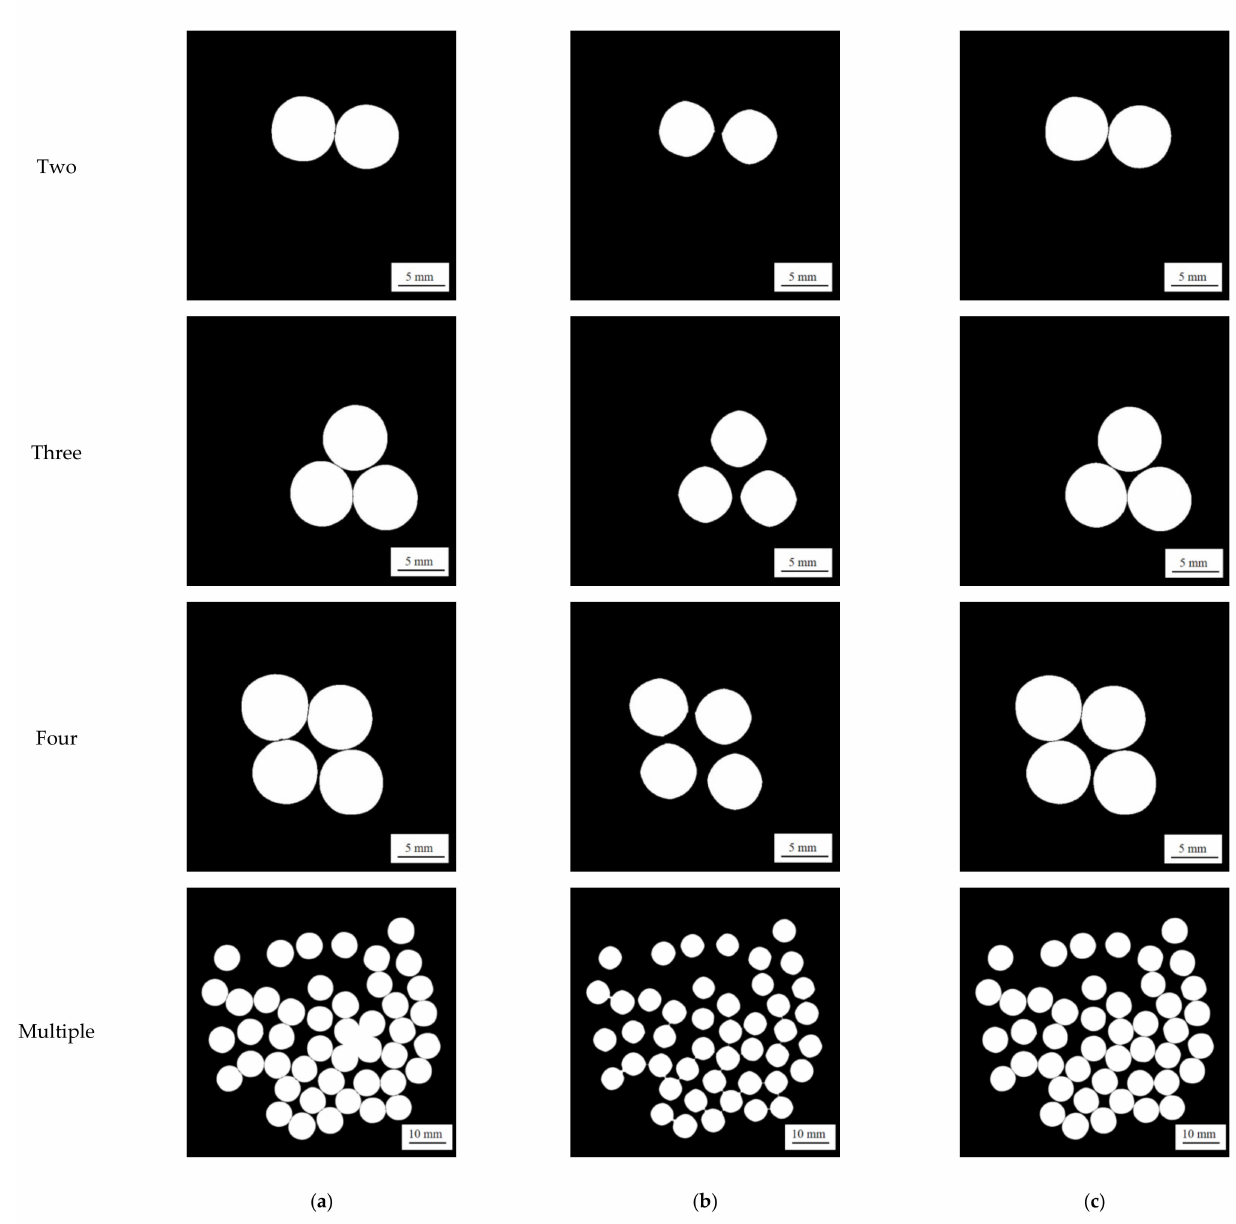
Figure 10. Different methods for different numbers of tangent pearls’ segmentation results. ( a ) Water- shed algorithm; ( b ) morphological algorithm; ( c ) proposed